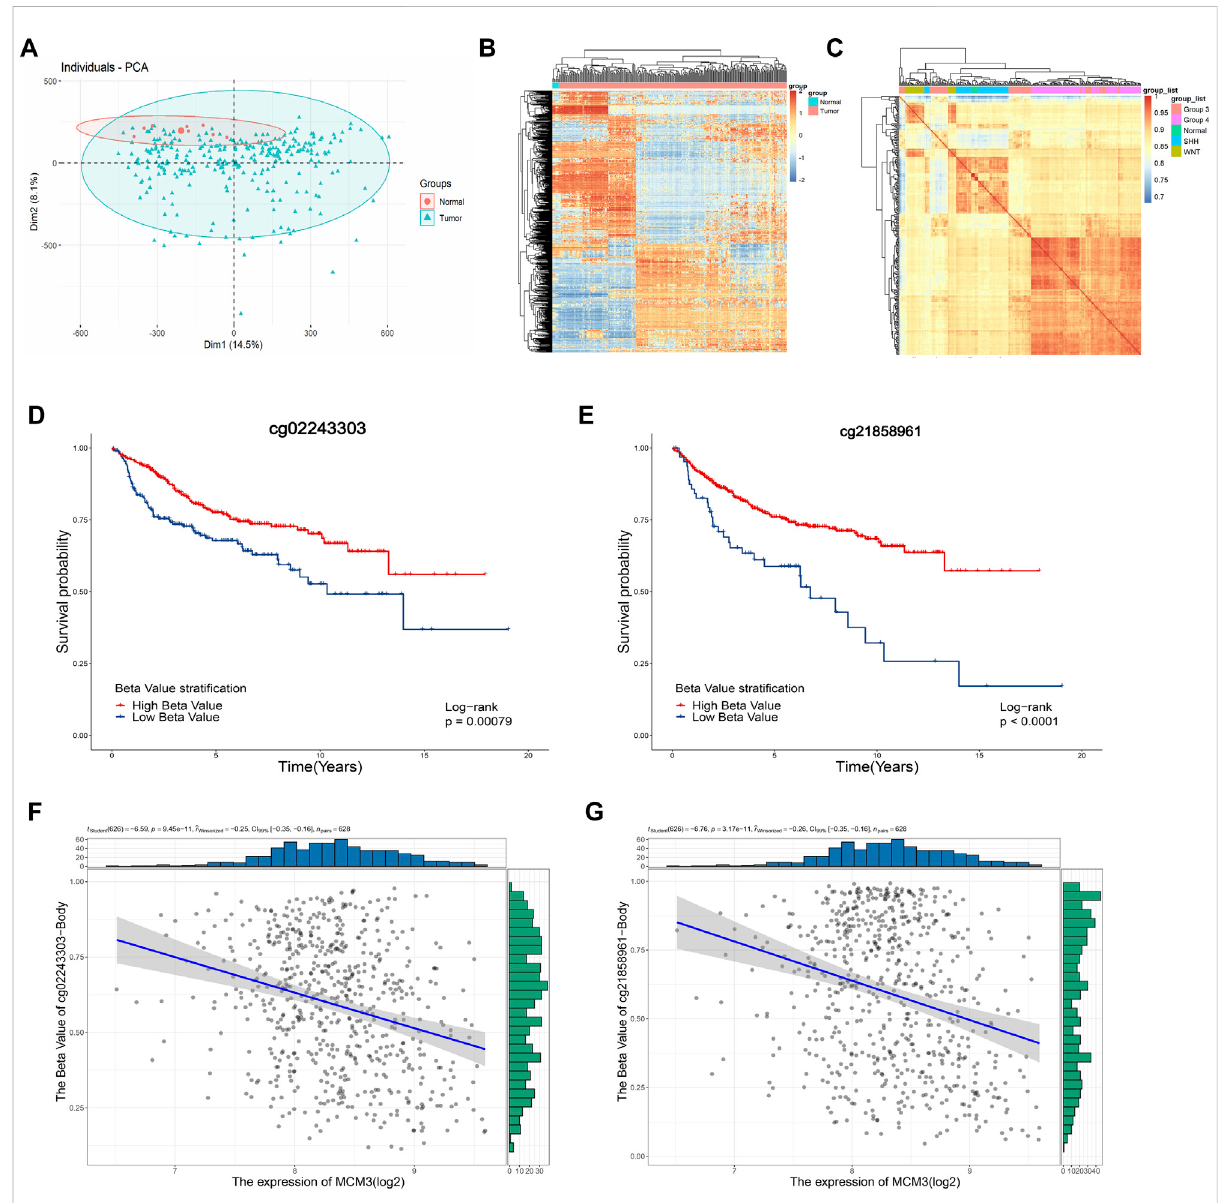
FIGURE 6 The PCA and heatmap showing the signi fi cant difference between normal and tumor samples (A,B) and the high correlation within groups (C) . The “ cg02243303 ” and “ cg2185896 ” probes are signi fi cantly associated with OS (D,E) and negatively correlated with MCM3 expression (F,G)